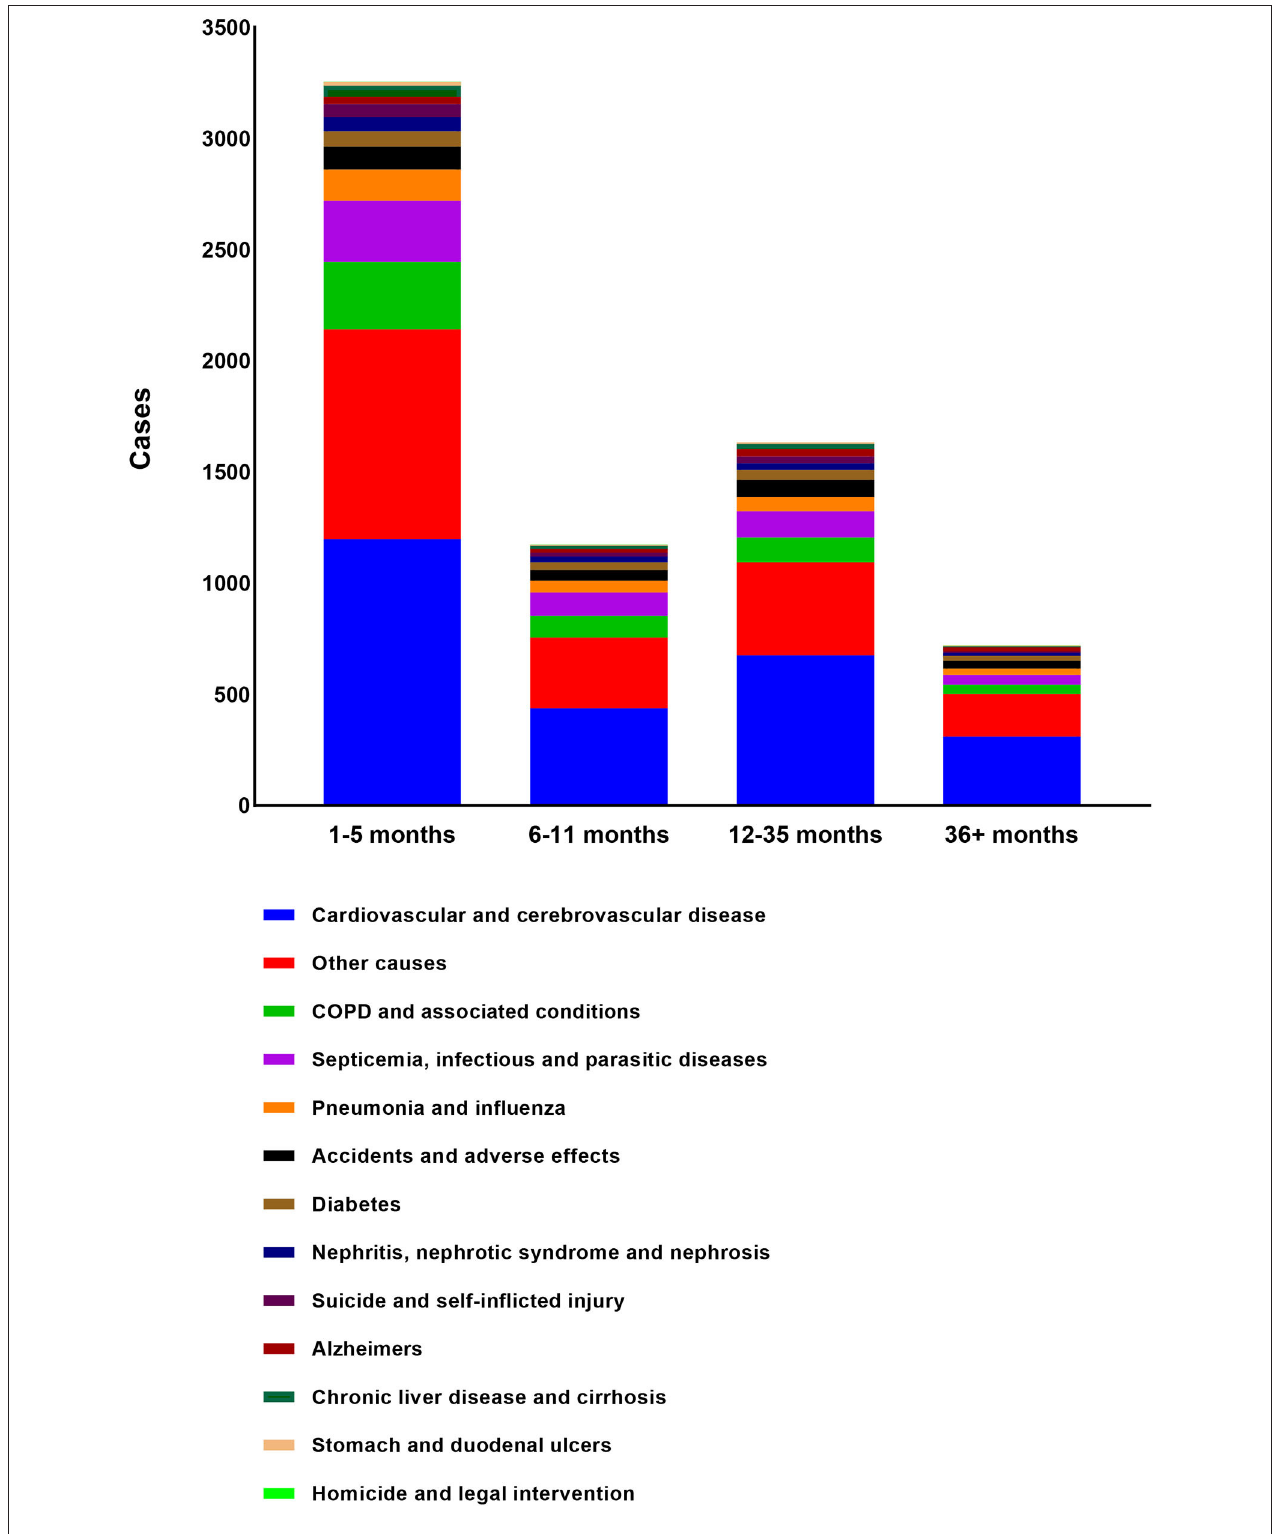
FIGURE 4 | The frequencies of non-cancer COD among different death